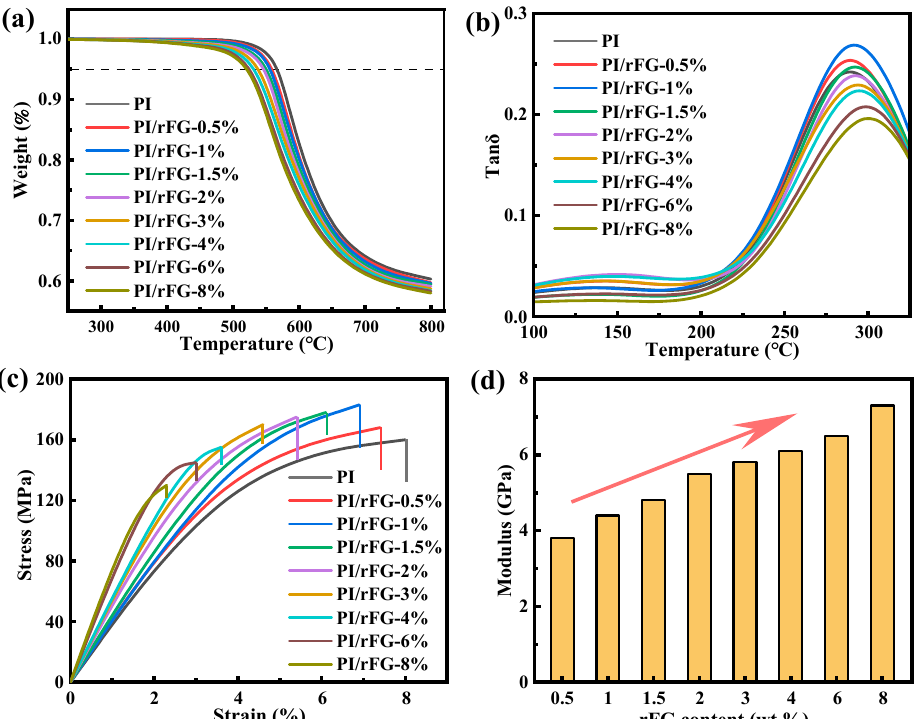
Figure 3. The thermal property and mechanical properties of the PI/rFG composite films. ( a ) Thermogravimetric analysis (TGA); ( b ) dynamic mechanical analysis (DMA); ( c ) stress–strain curve of the PI/rFG composite films; ( d ) modulus corresponding to the rFG content. Table 1. The thermal and mechanical properties of the PI/rFG composite films.